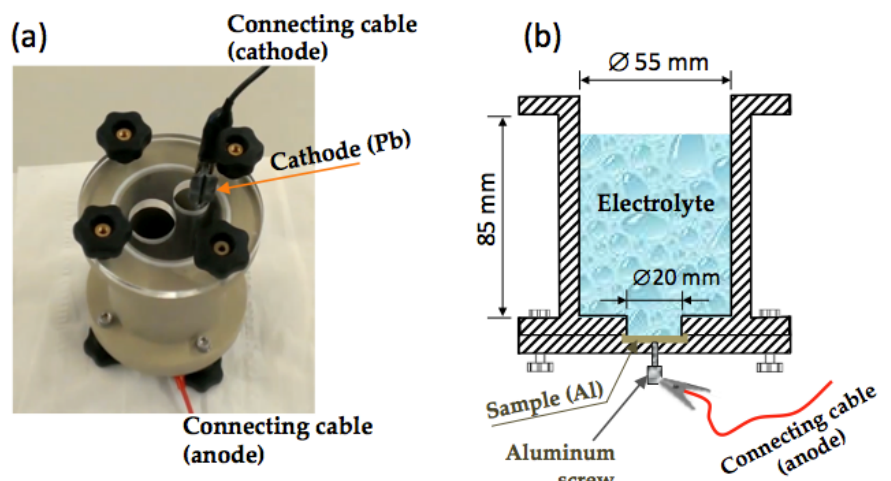
Figure 2. The custom-made electrochemical cell: ( a ) the photograph of the anodization cell showing the position of the cathode and anode and their connecting cables, and ( b ) schematic representation of the anodization cell presenting its main dimensions and showing the circular hole in the bottom base where the aluminium sample (anode) is placed.